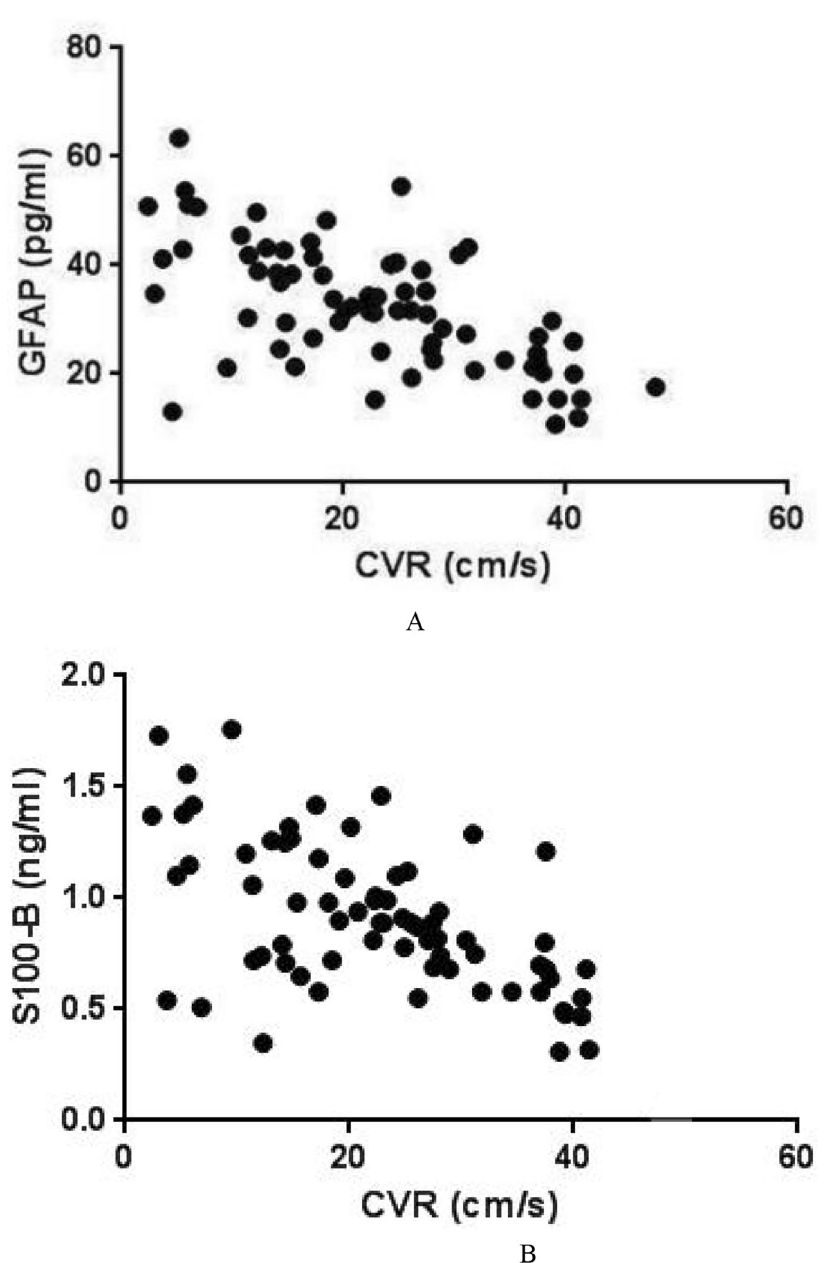
Figure 3. Association between serum GFAP, S100B and CVR at 30 days. Association between serum GFAP ( A , r = − 0.629, P < 0.0001), S100B ( B , r = − 0.604, P < 0.0001) and CVR at 30 days after CAS using Pearson’s correlation